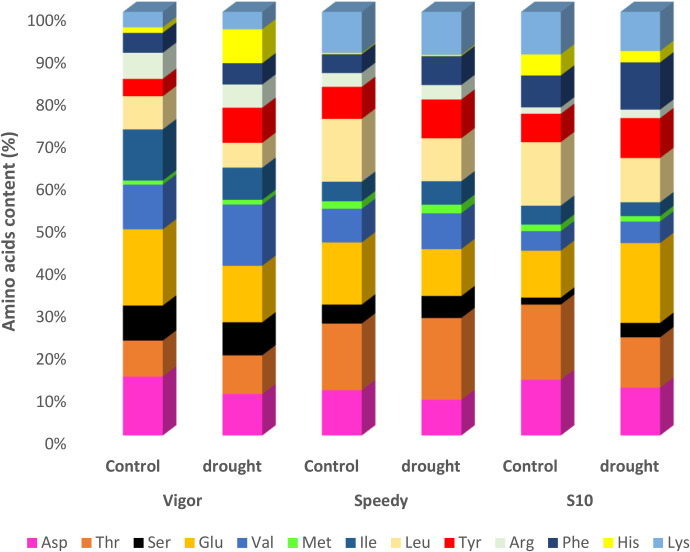
Amino acids content including Aspartic acid, Threonine, Serine, Glutamic acid, Valine, Methionine, Isoleucine, Leucine, Tyrosine, Arginine, Phenylalanine, Histidine and Lysine of three genotypes of Lolium perenne under drought stress.